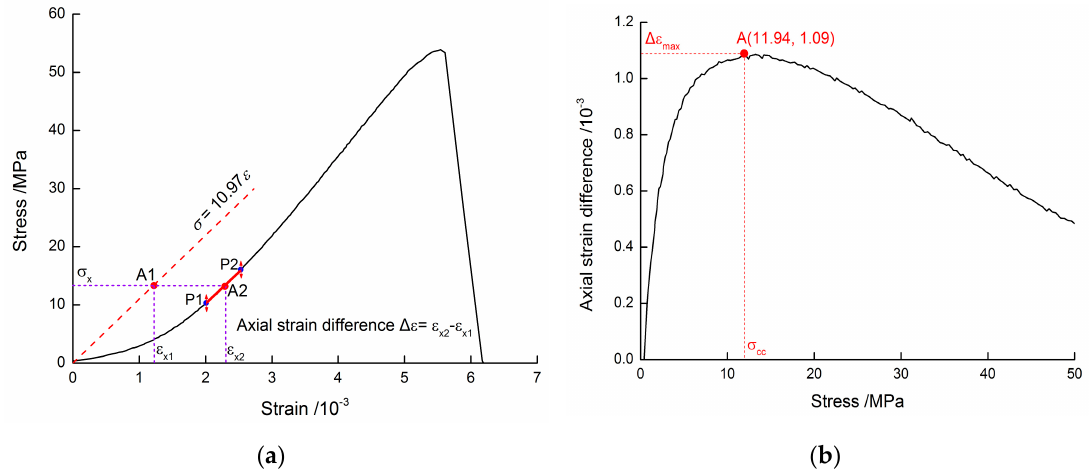
Figure 11. Determination of crack closure stress of specimen Sq-0-A-1: ( a ) schematic diagram of axial strain difference and ( b ) location of Point A with the maximum axial strain difference.